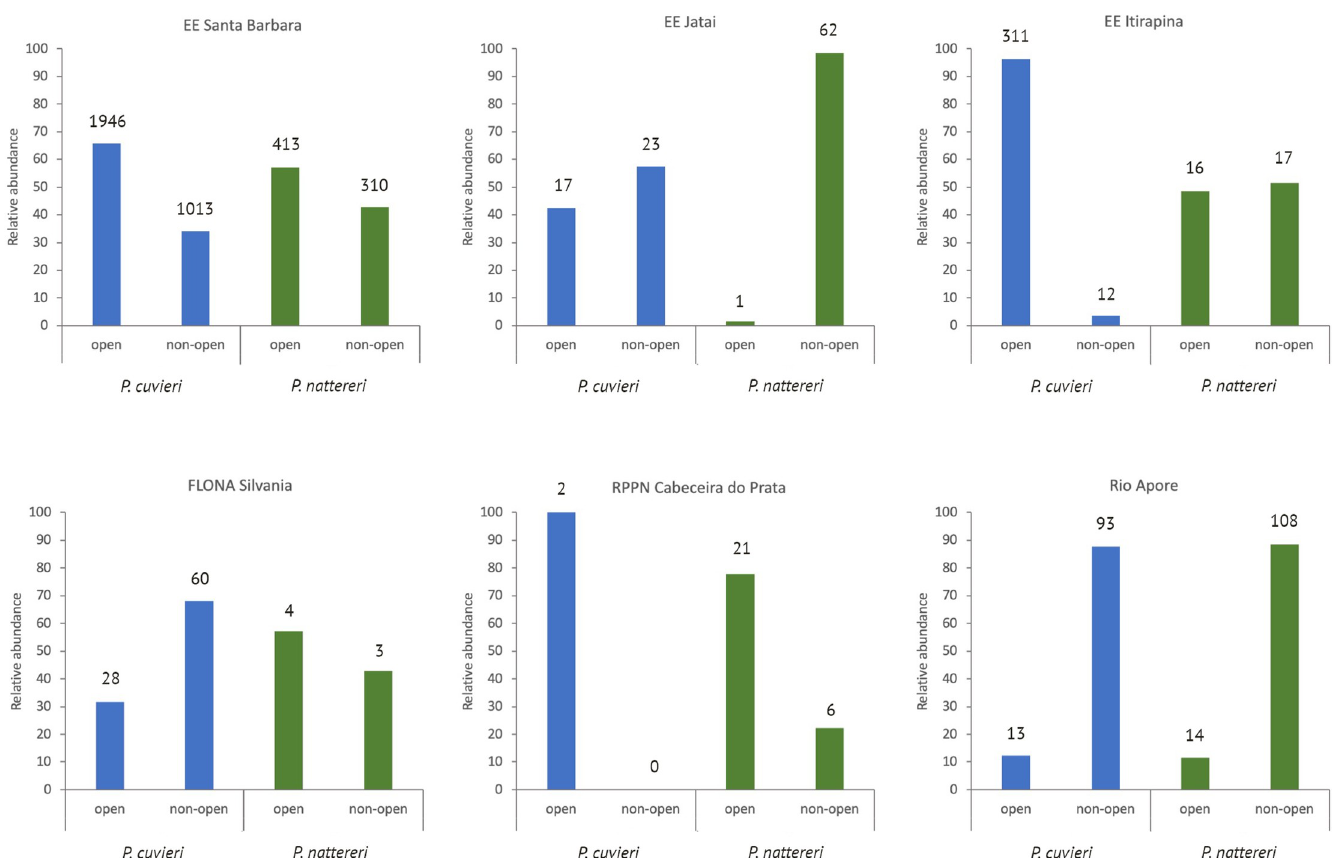
Fig 2. Relative abundance (in %) of P . cuvieri (blue bars) and P . nattereri (green bars) in open and non-open areas in Cerrado (see S2 Fig). Sources of data: [45–50]. Detailed data on the abundance of the frogs in different vegetation types are in S5 Table.